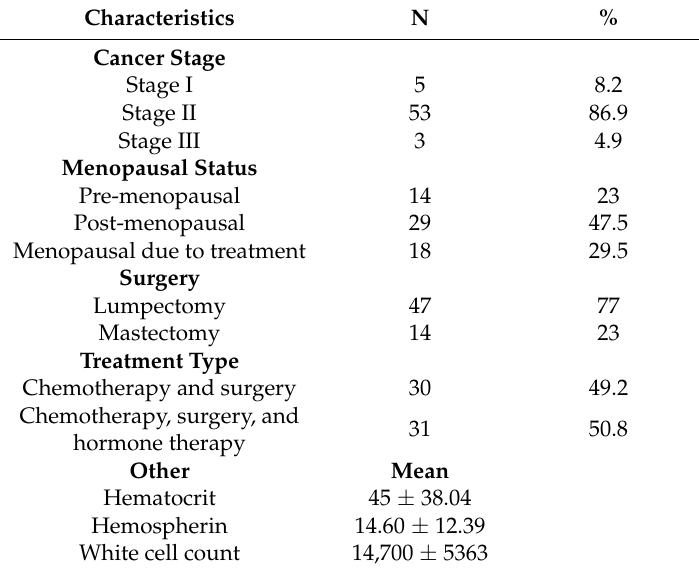
Table 2. Clinical characteristics of the